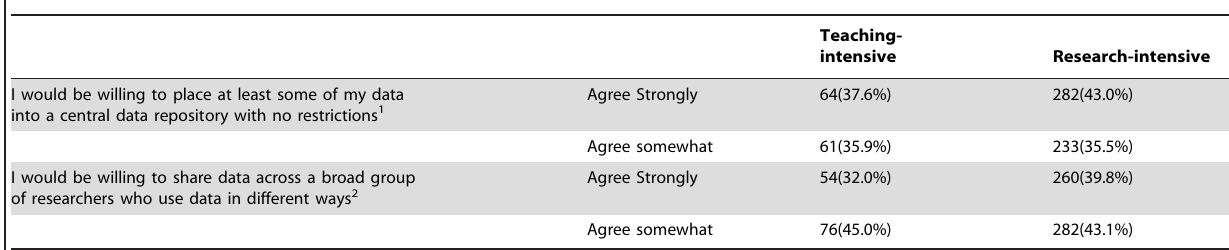
Table 28. Conditions for data sharing by activity.